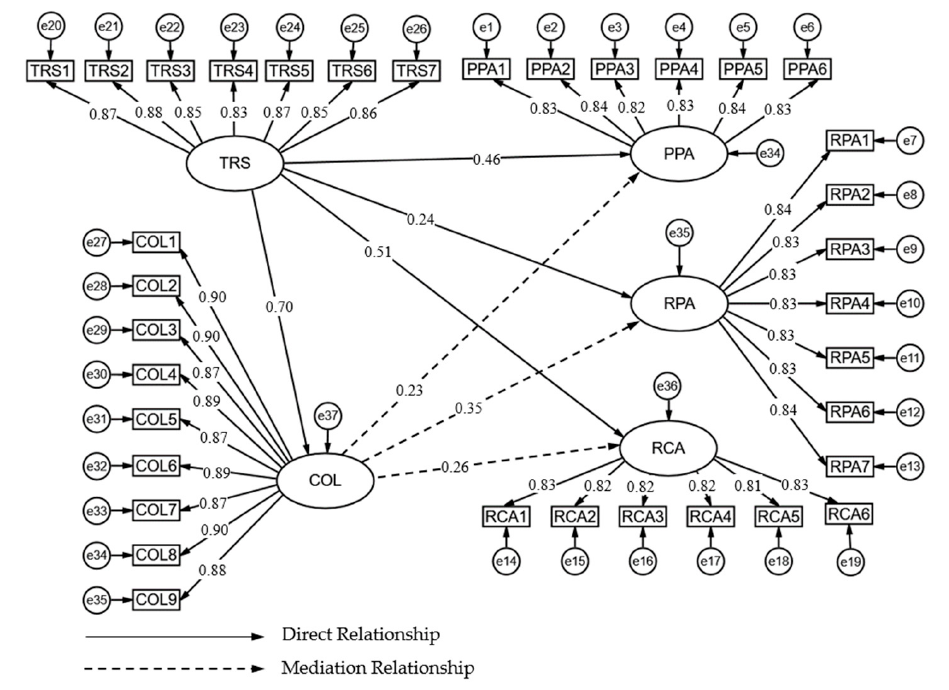
Figure 2. Structure Equation Model.